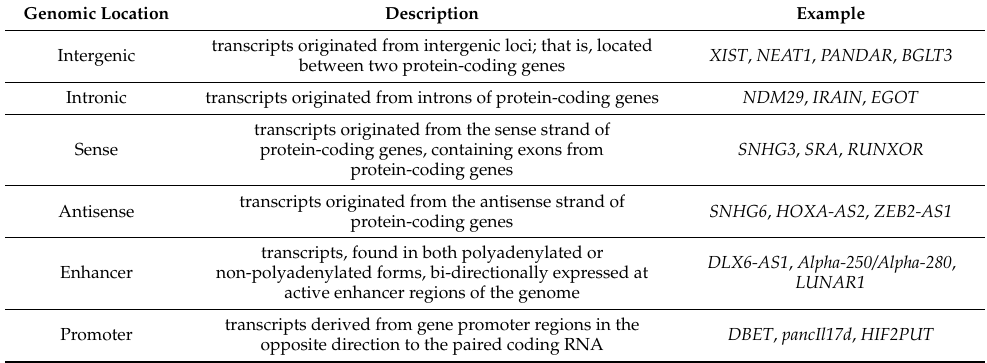
Table 2. Classification of lncRNAs.